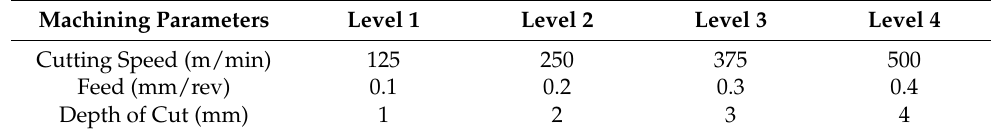
Table 1. L 16 experimental plan for conventional speed machining (CSM).